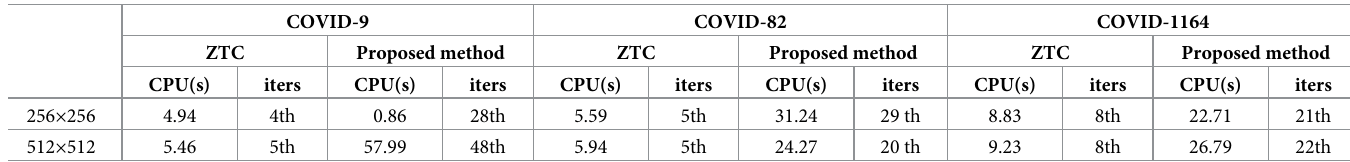
where, N is the number of pixels in the object that are correctly segmented, N gs of pixels in the ground truth object, N is the number of pixels in the segmented object. s In Table 4, we list the Dice metric numbers obtained in PASCAL-VOC2012 dataset to eval- uate the quality of our segmentation results. The data shows that while the proposed method can achieve similar results as the ALM method, the runtime had been reduced to approxi- mately one-sixth.